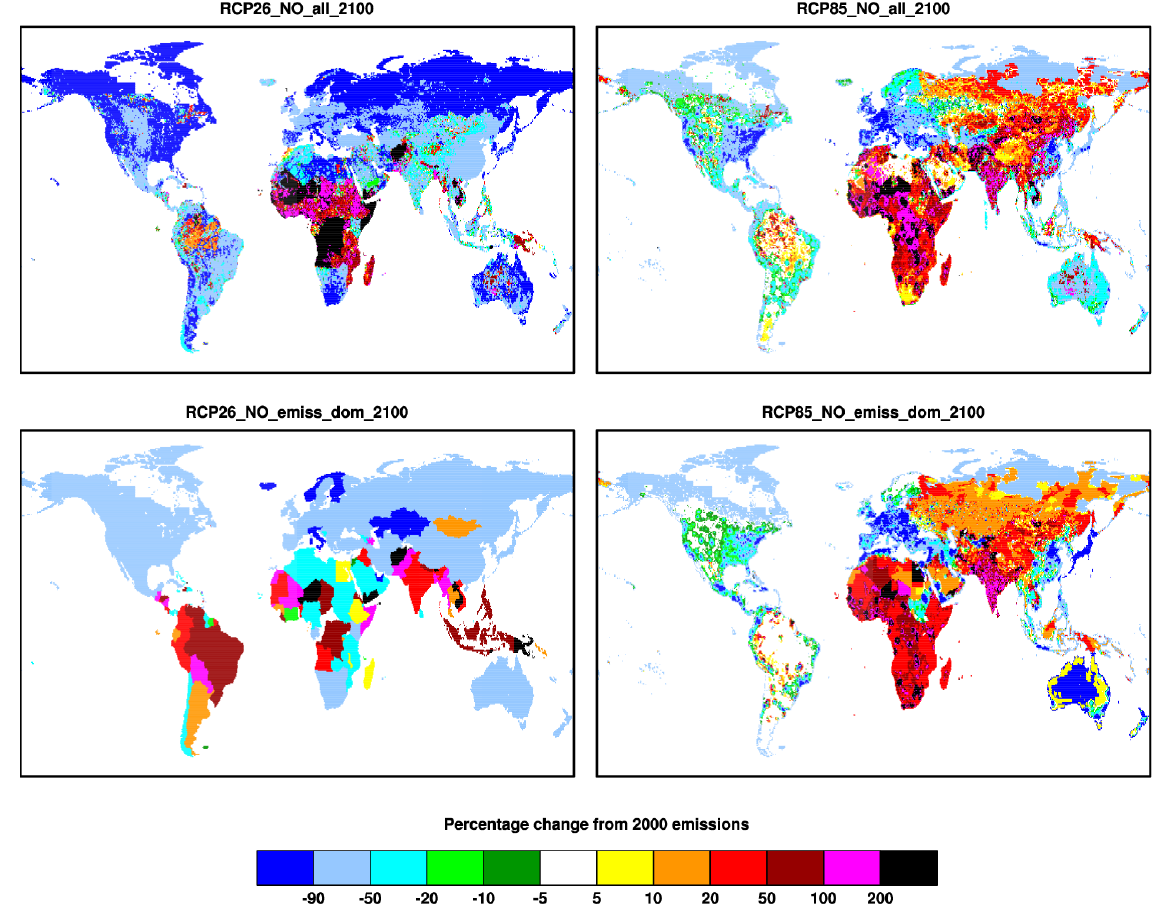
Fig. 4. Percentage change in 2100 NO emissions relative to 2000 for RCP-2.6 (left) and RCP-8.5 (right). The top row shows total NO emissions, and the bottom row shows only emissions from the domestic